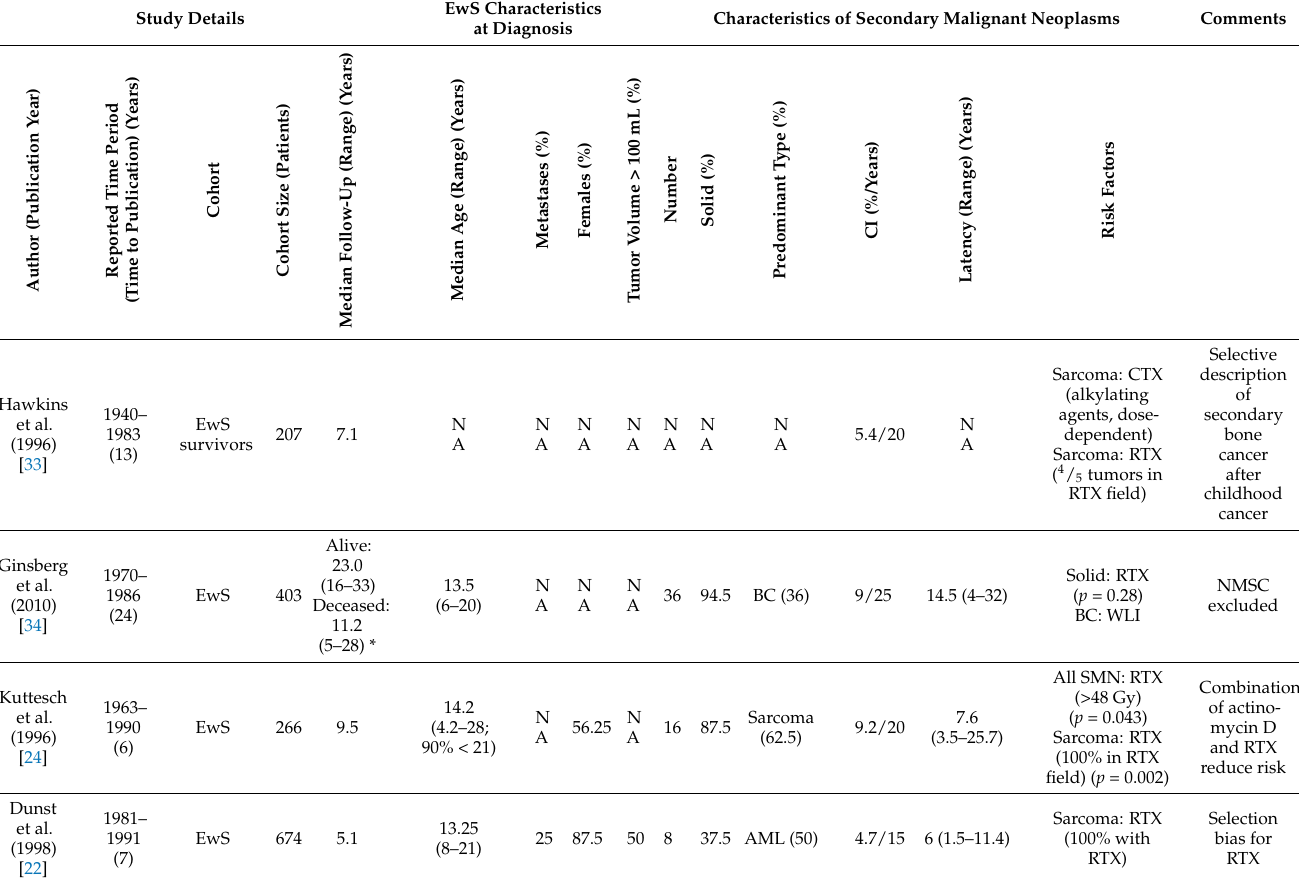
Table 4. Summary of data from secondary malignant neoplasms (SMNs) studies after